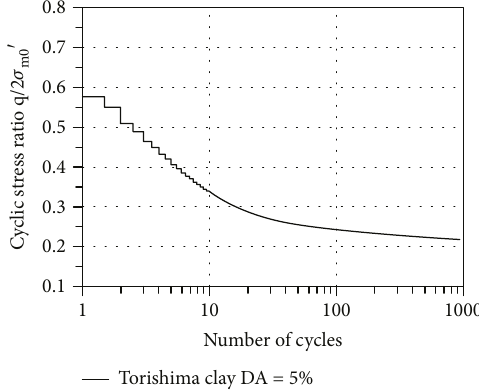
Figure 13: Liquefaction resistance curve for Torishima